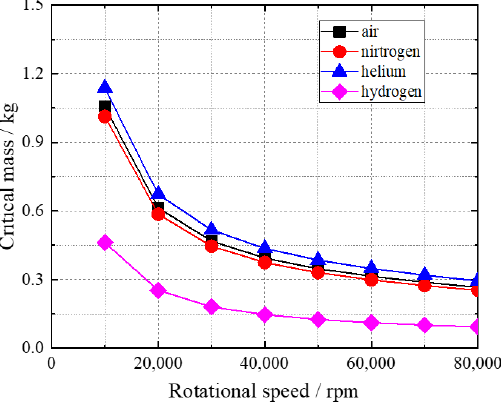
Figure 8. Critical masses of the bearings with rotational speed for the four different gases.